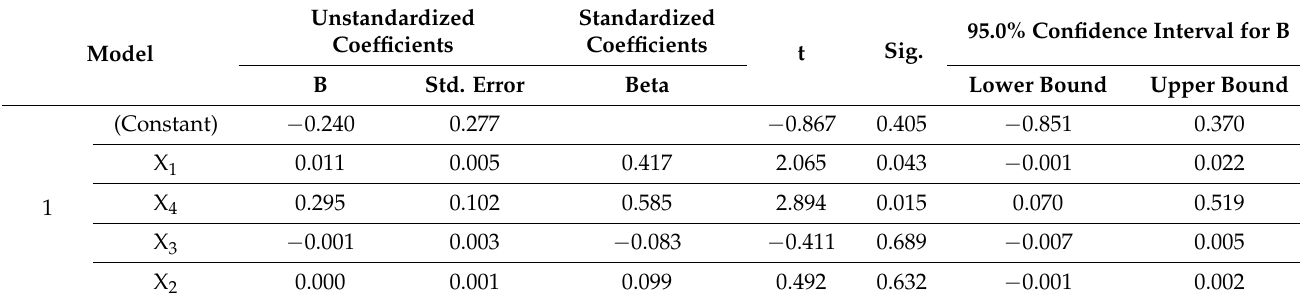
Table 5. Determination of coefficients with four